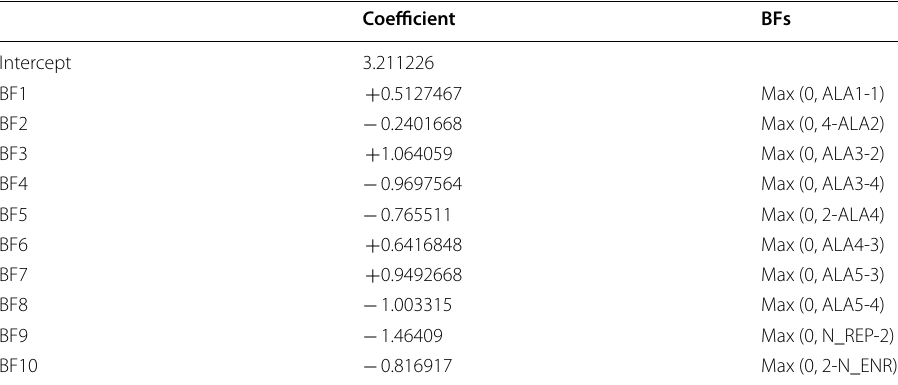
Table 16 BFs for the MARS model for Markets and behavior course